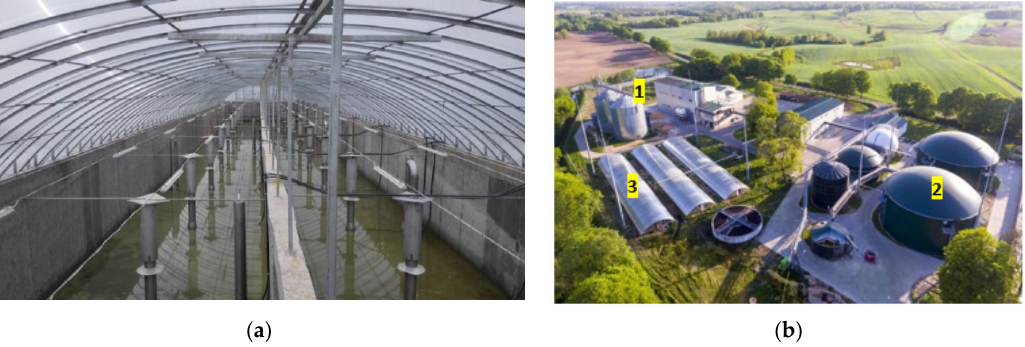
Figure 9. Photobioreactor for growing microalgae based on digestate (( a ) overview, ( b ) placement